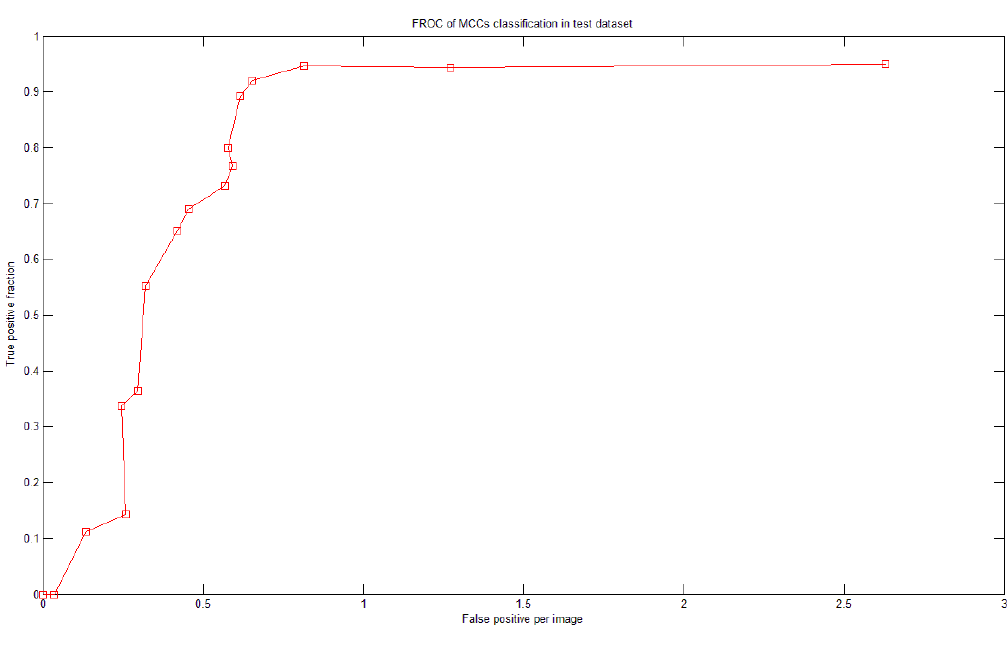
Figure 11. The fROC curve for the test dataset.